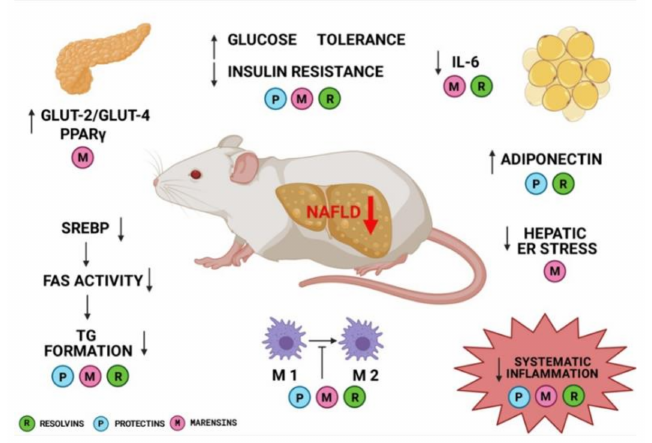
Figure 1. Resolvins’, protectins’ and marensins’ mechanisms of action. Created with BioRender.com (22 April